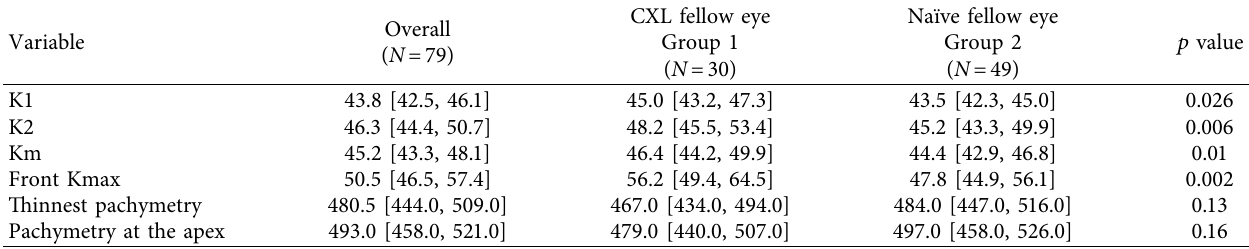
Table 2: Baseline disease severity in crosslinked and na¨ıve fellow